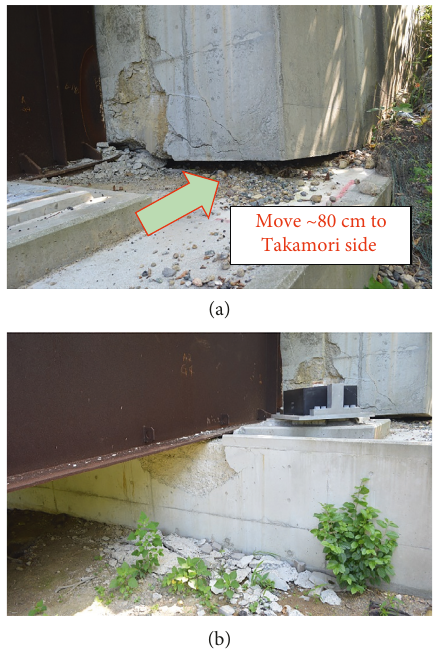
Figure 13: Damage to abutment A2 (interior).